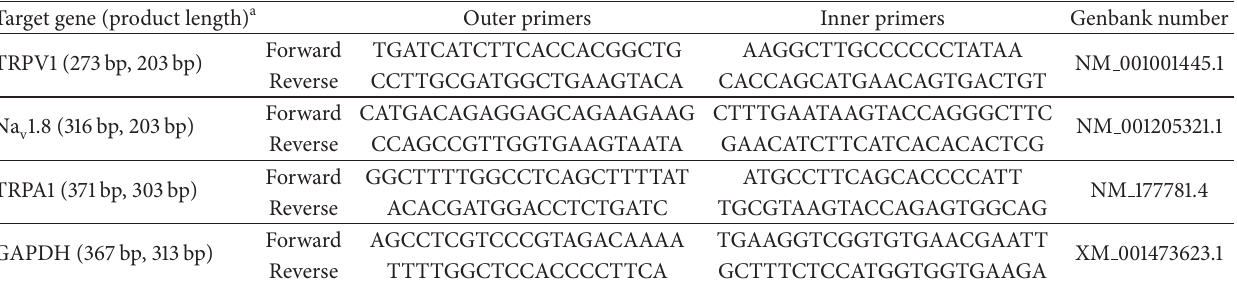
Table 1: List of DNA primer sequences designed for single-cell